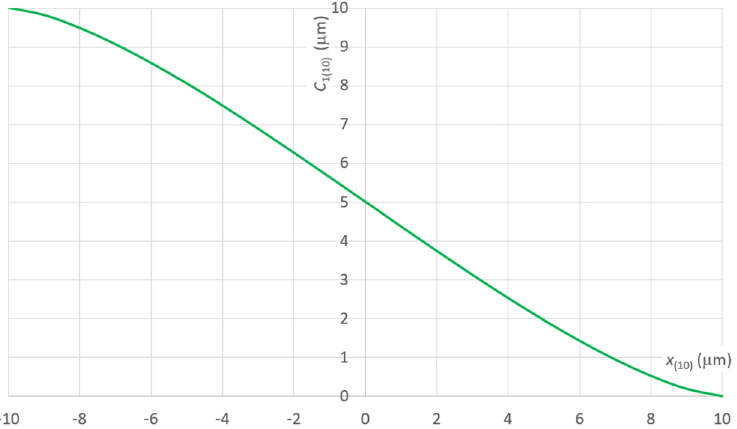
Figure 6. Variation of the value of the amplitude of the first harmonic component C 1(10) of the amplitude spectrum of the outline of eccentricity depending on the displacement of the support x (10) , assuming that the eccentricity value e (10) = 10 µm.